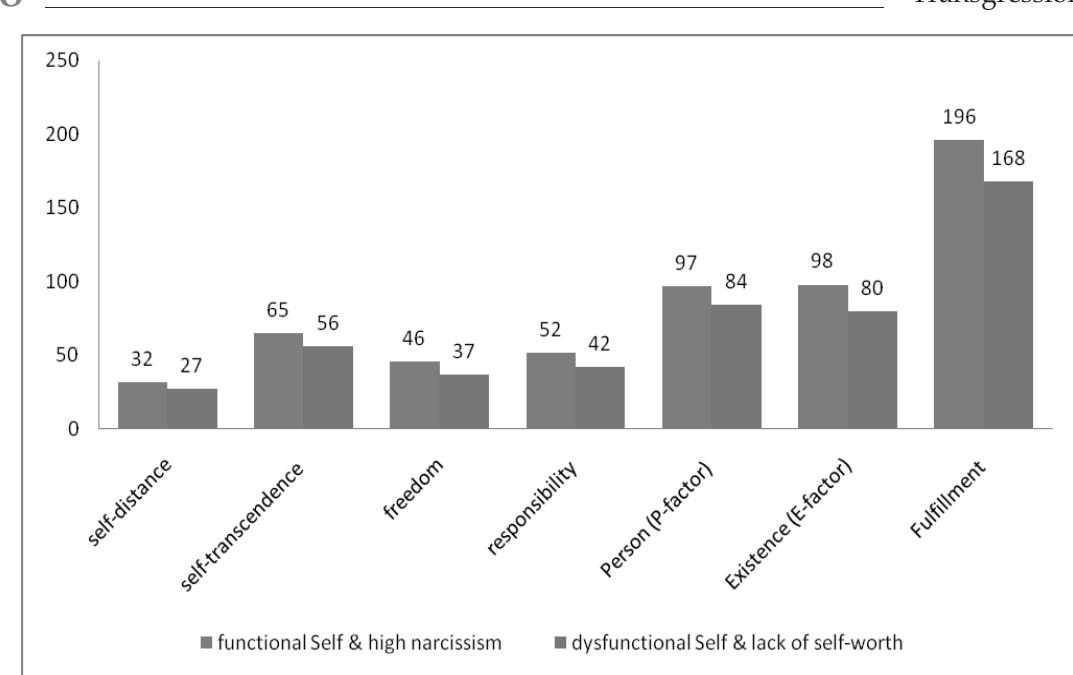
Figure 3. Graphic depiction of existential ful (cid:192) llment of distinct narcissistic self-regula- tion